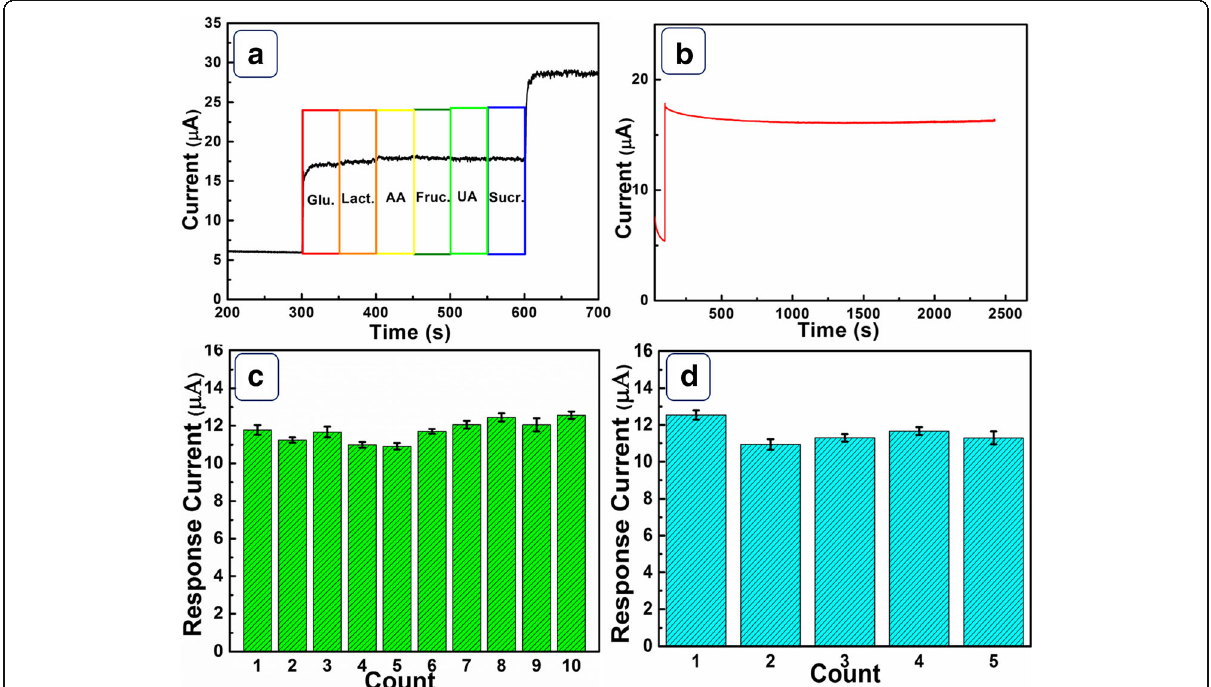
Fig. 6 a The selectivity measurement of Ni(OH) 2 HPA electrode at 0.6 V. The added glucose and all the interfering species are 0.1 mM and 0.01 mM, respectively. b The stability of Ni(OH) 2 HPA electrode within 2400 s. c Ten measurements of one Ni(OH) 2 HPA electrode towards 0.1 mM glucose. d Current responses of five Ni(OH) 2 HPA electrodes towards 0.1 mM glucose